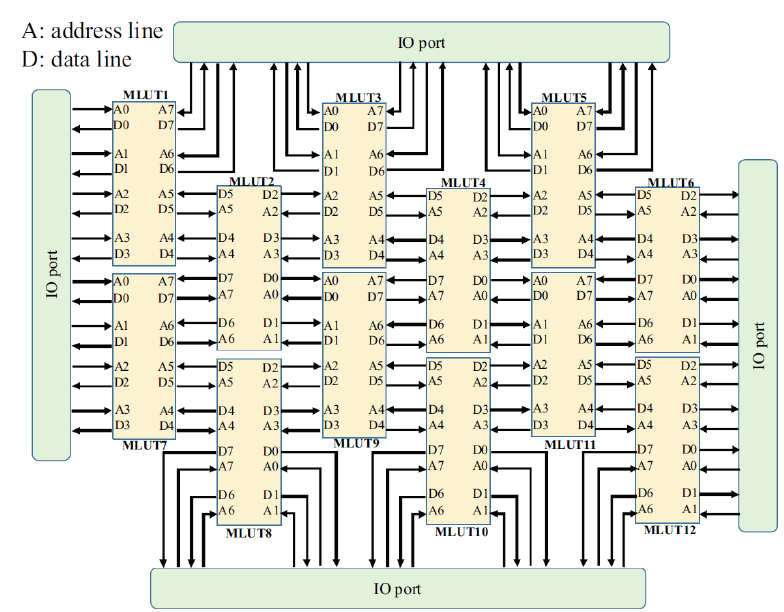
Figure 1. The structure of